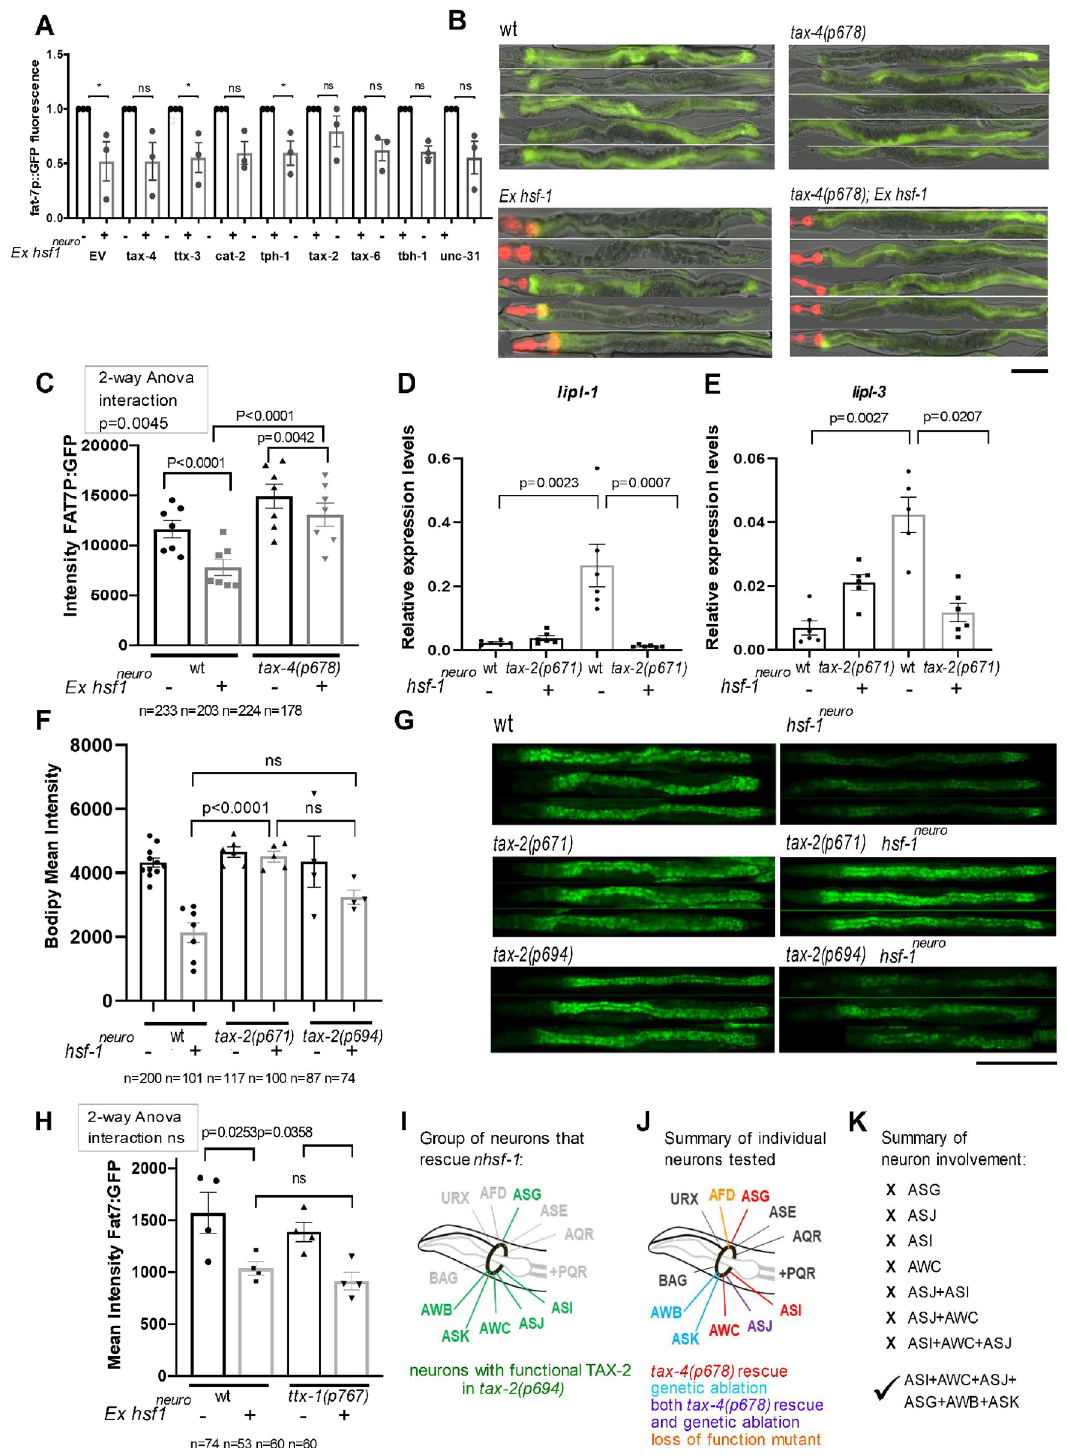
Fig 3. Neuronal cells expressing the cGMP gated cation channel TAX-2/TAX-4 are required to modulate the effect of neuronal stress on fat-remodeling in the intestine. (A) RNAi-based screen for suppressors of the repressive effect of hsf-1 neuro on fat-7 expression (details in Methods). Ex hsf-1 neuro ; fat-7p :: GFP; rrf-3 (MOC201) were treated with RNAi against 8 genes expressed in neuronal cells that are known or suspected to influence fat metabolism. The graph compares mean expression values of RNAi-fed Ex hsf-1 neuro (+/ − ) pairs, where the average mean intensity values of GFP driven by fat-7p :: GFP in animals containing the Ex hsf-1 neuro